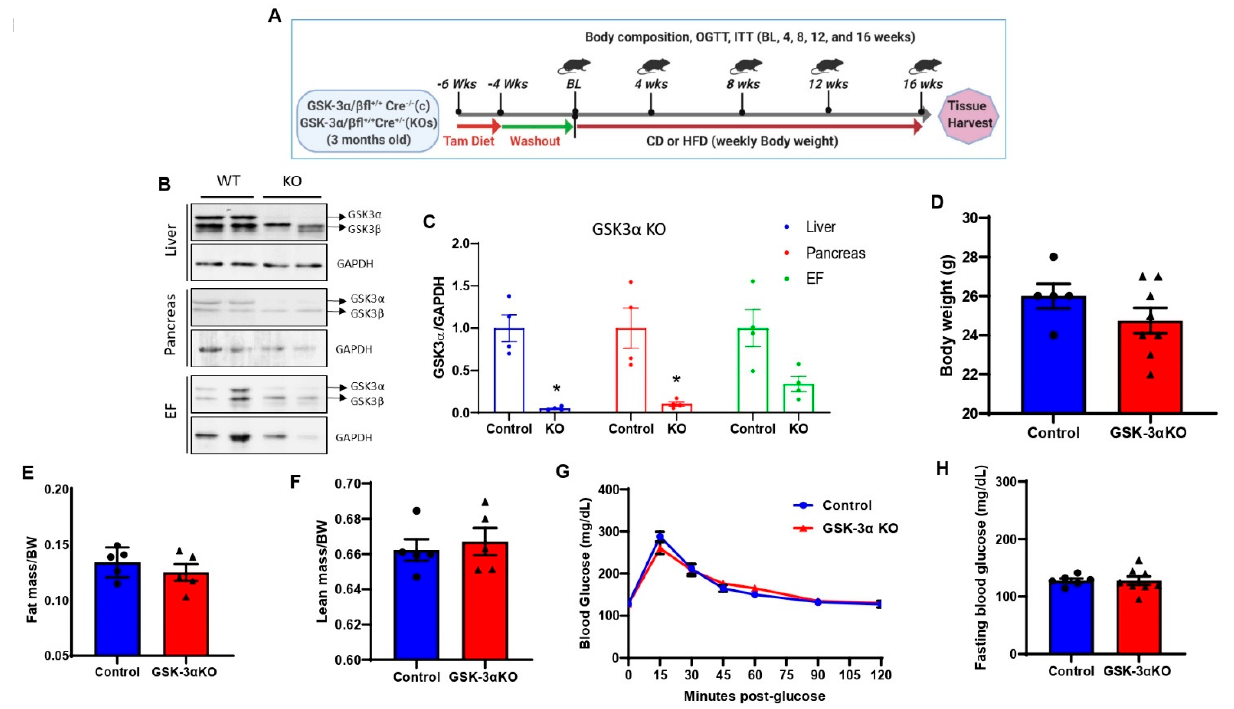
Figure 1. Creation and characterization of global conditional GSK-3 α KO mouse model. ( A ) Experimental design, three-month-old male controls, or GSK-3 KO mice were subjected to a tamoxifen diet for 2 weeks followed by 4 weeks of washout. Following the washout period, control and GSK-3 KO mice were fed a CD and an HFD, respectively, for sixteen weeks. ( B ) Representative immunoblot showing the specific deletion of GSK-3 α in the liver, pancreas, and epididymal fat in GSK-3 α KO mice at the termination of the experiment (16 weeks post chow/HFD treatment). The replicates of different samples were analyzed. ( C ) Quantification of GSK-3 α expression from control and GSK-3 α KO